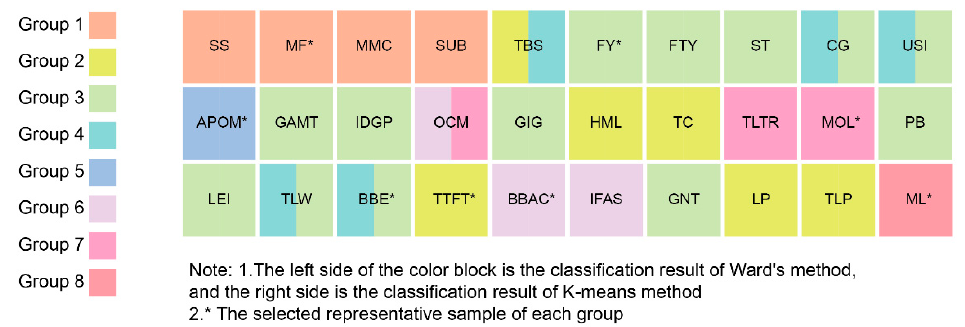
Figure 2. Classification outcomes of the picture book samples and the selection results of the representative samples.